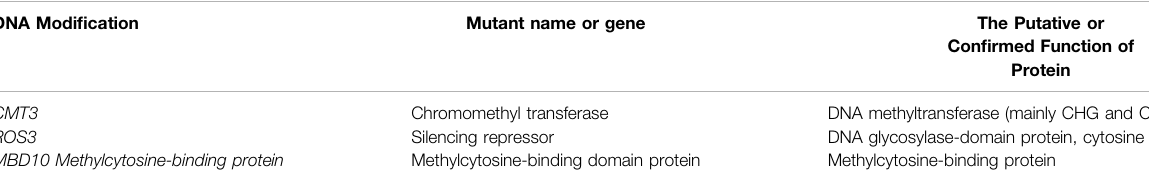
TABLE 1 | Model plant Arabidopsis thaliana and their epigenetic regulation ( Pikaard and Mittelsten, 2014 ) DNA Modi fi cation